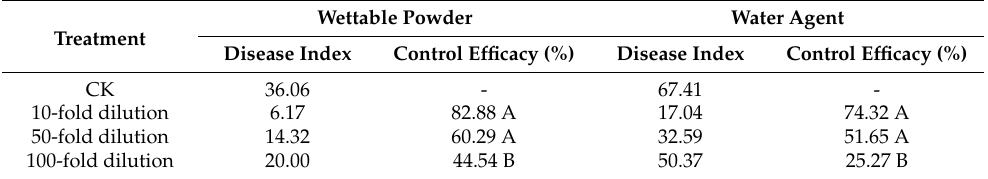
Table 3. Control efficacy of XZ18-3 wettable powder on wheat sharp eyespot disease. Different